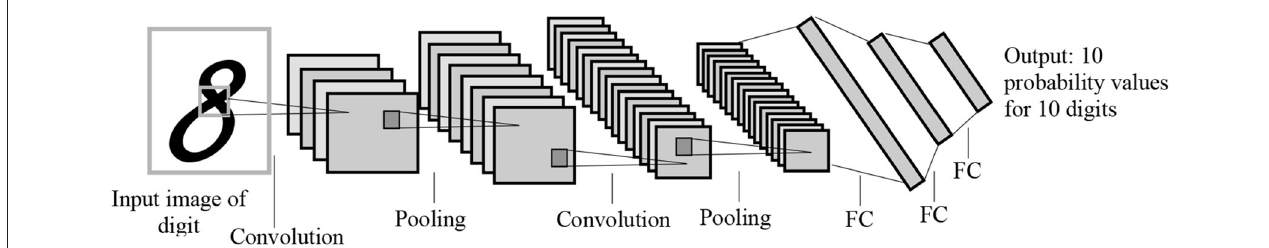
FIGURE 1 | The LeNet architecture for letter recognition, one of the first CNN architectures for image processing. FC, Fully-connected layer. The architecture was designed for handwritten digit recognition.